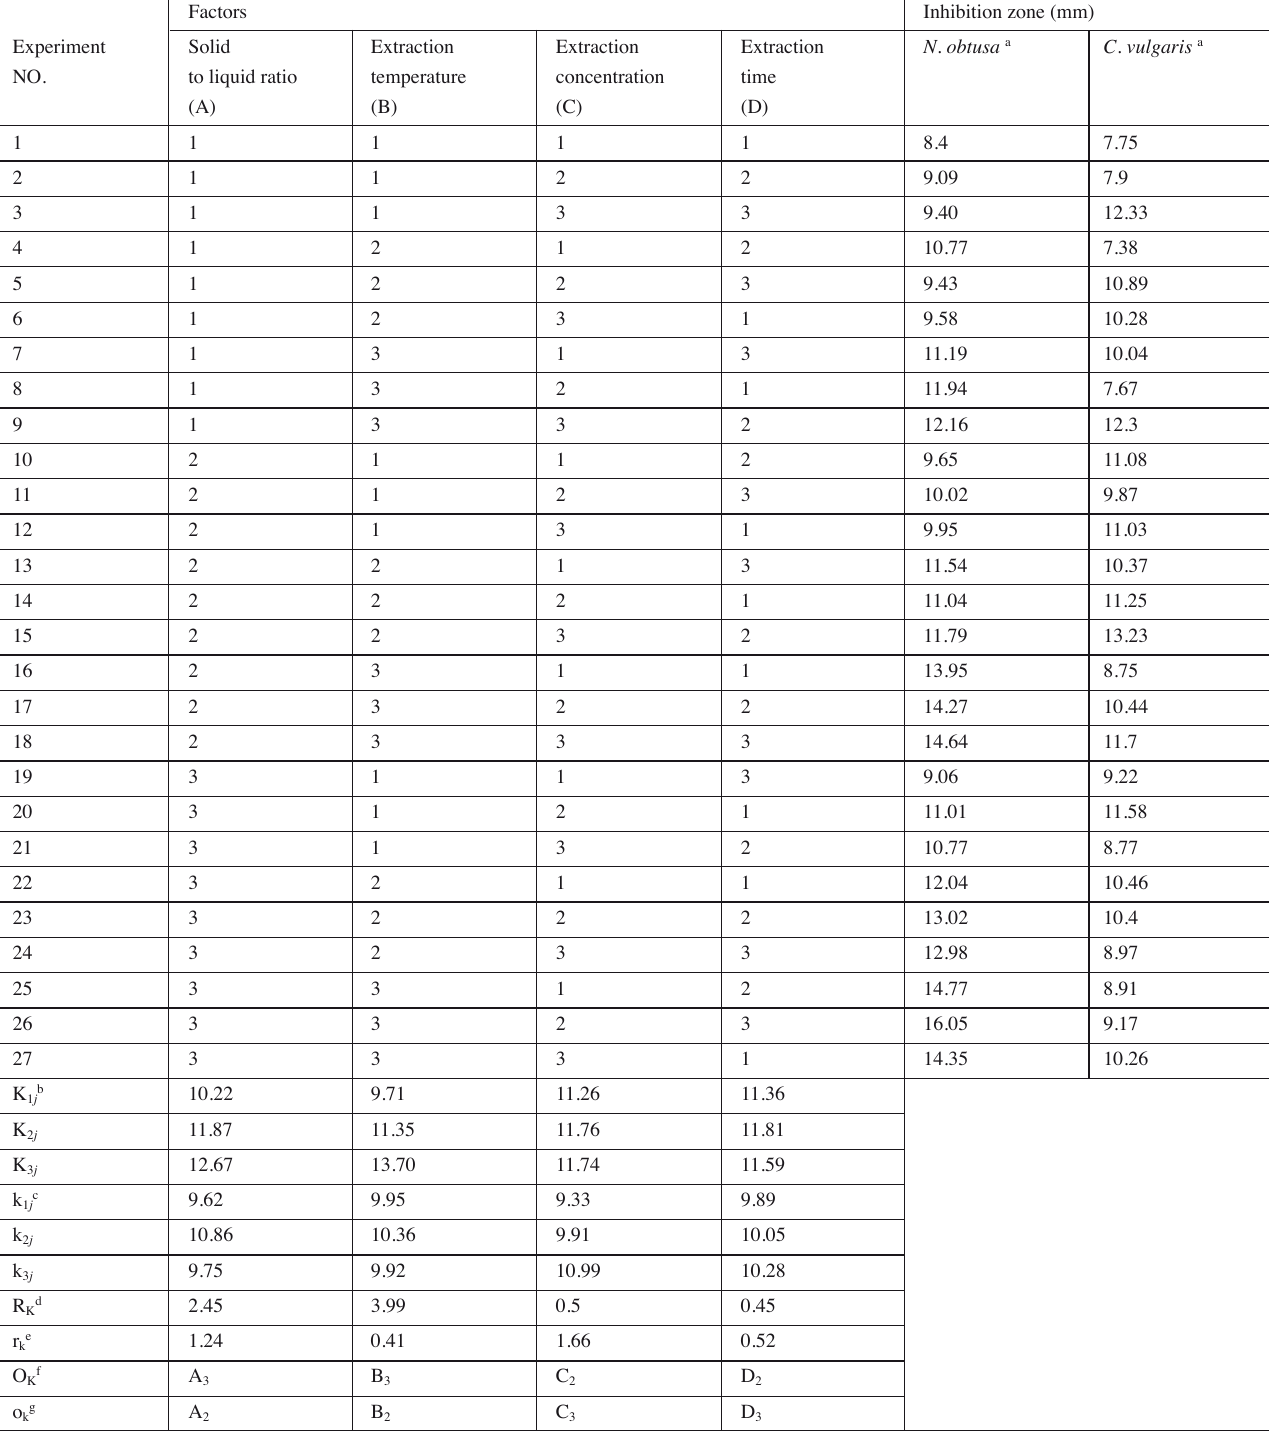
Tab. 4: Result analysis of orthogonal experiments L 27 (3 13